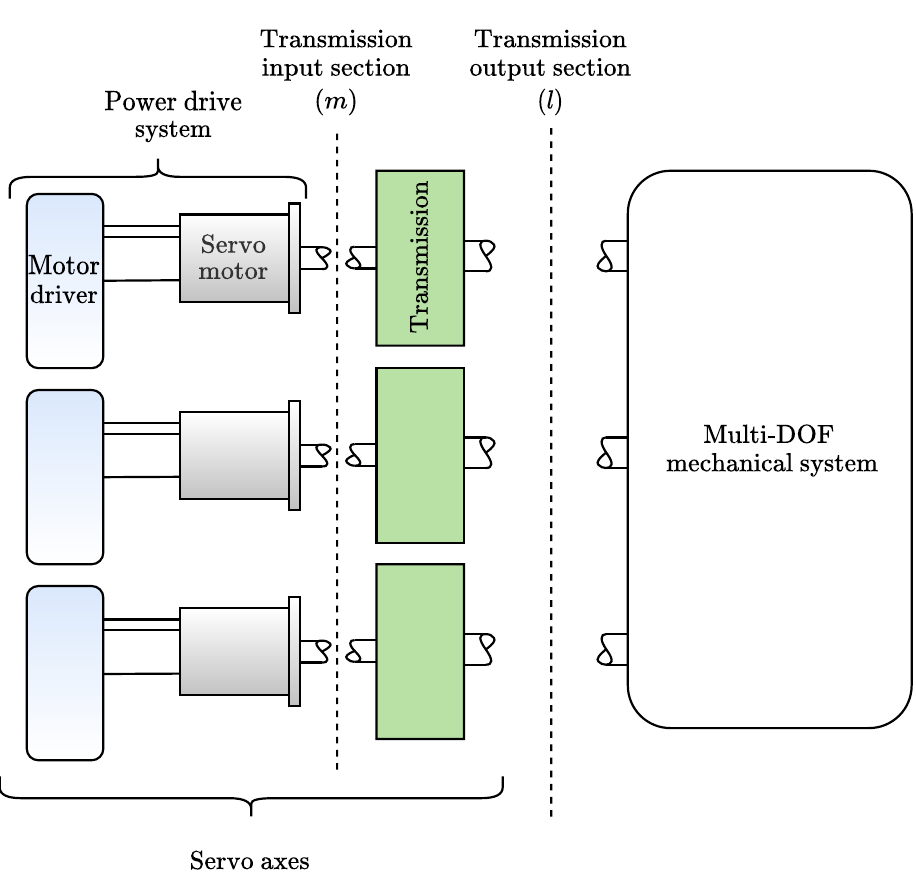
Figure 1. Schematic overview of a multi-axis mechatronic system and of its conceptual